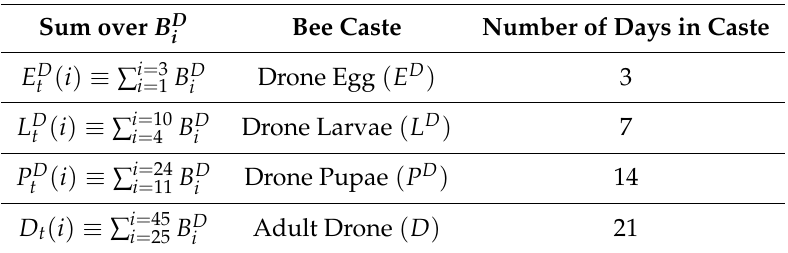
Table 2. Day ranges used to calculate drone demographics.